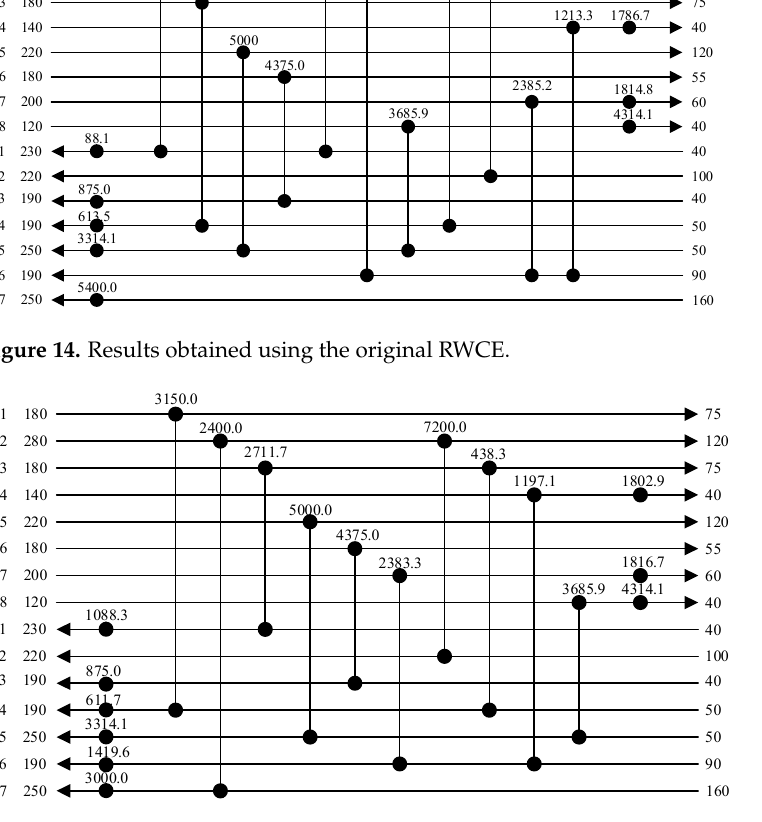
Figure 15. RWCE optimization results of the participatory evolutionary strategy for streams.